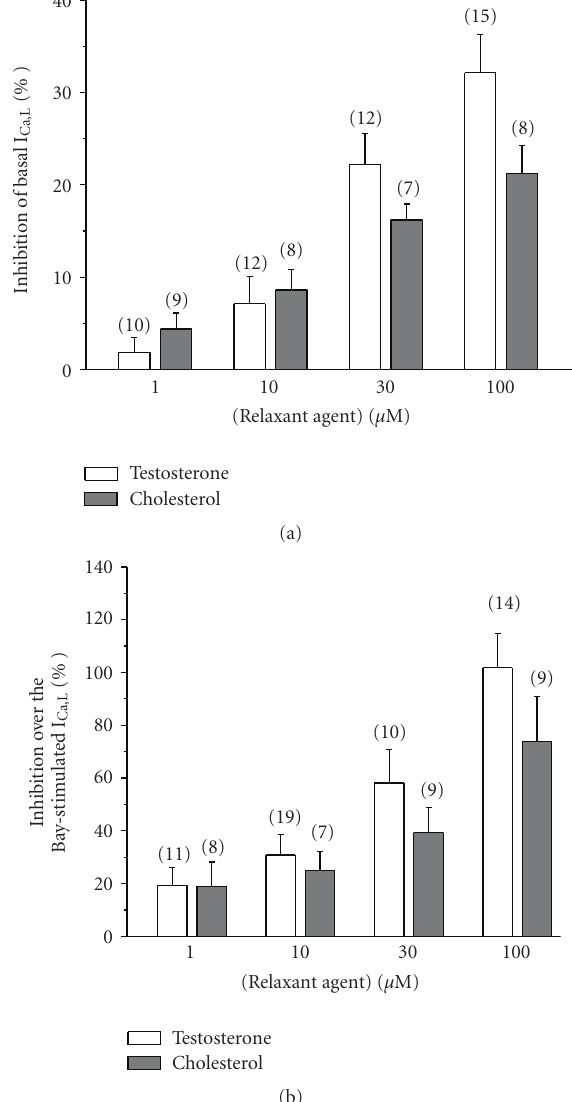
Figure 5: E ff ects of testosterone and cholesterol on I Ca,L in A7r5 cells. Di ff erent concentrations (1–100 μ M) of testosterone and cholesterol inhibit basal I Ca,L (a) and BAY-stimulated (10nM) I Ca,L (b). Each column represents the mean value ± SEM (indicated in vertical bars), in percent of the basal (a) or BAY-stimulated (b) I Ca,L from the number of experiments shown in